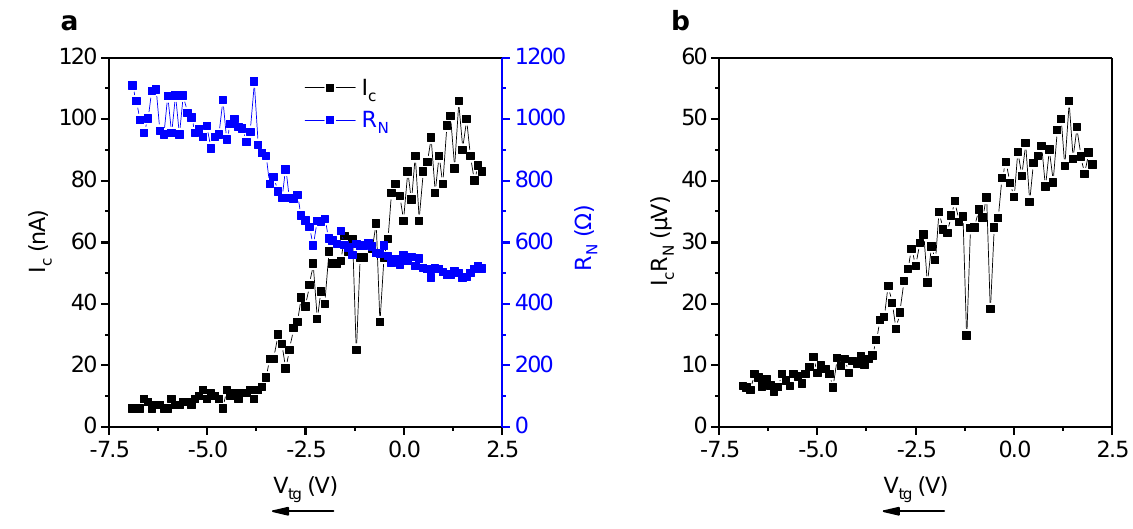
Figure 4. ( a ) I c and R N of device 2 for a range of top gate voltages. The supercurrent can be tuned close to zero at negative gate voltage. The arrow indicates the sweep direction of the gate voltage. ( b ) I c R N product of device 2 for a range of top gate voltages. The induced gap could be tuned by almost an order of magnitude over the voltage range.